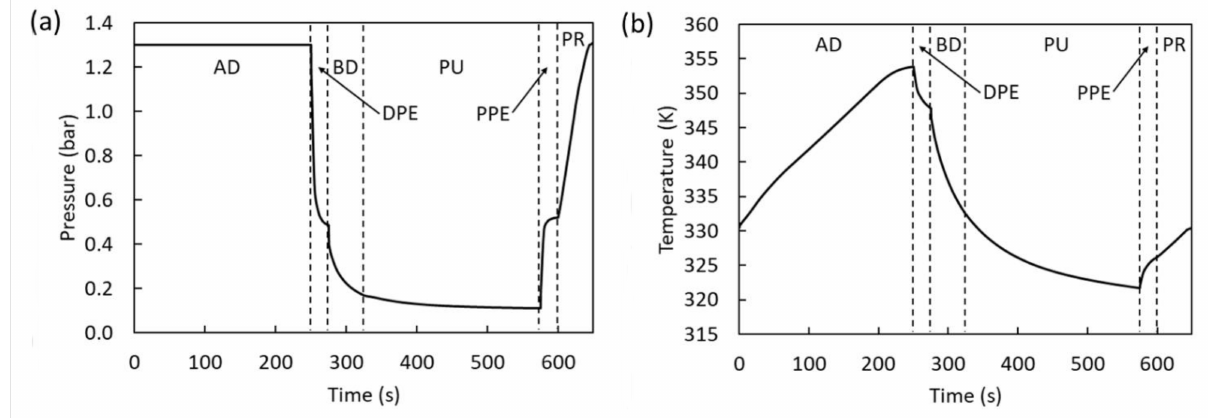
Figure 7. Profiles of ( a ) pressure and ( b ) temperature averaged over the bed length for a cycle at the cyclic steady state of the 2-bed, 6-step VPSA (Run 18).